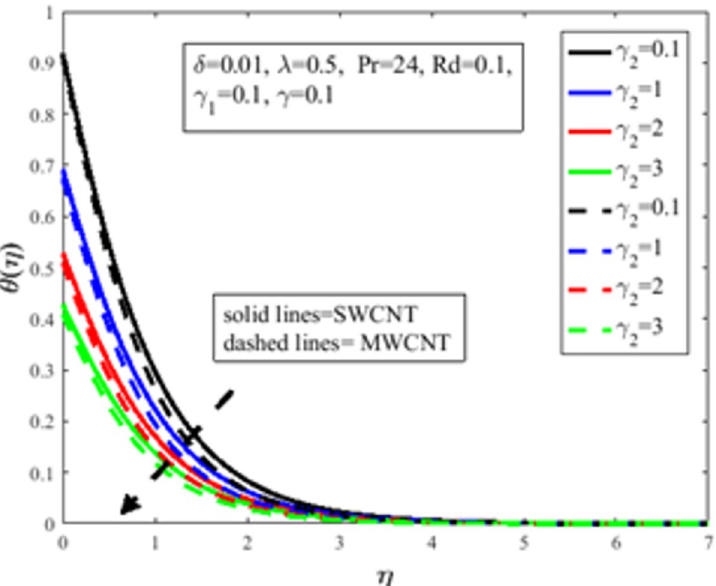
microorganisms from the liquids. Sun is the best source of thermal radiation. Radiations enhance the nanofluid temperature. In the presence of Rd heat enter more easily into the sys- tem which improves the fluid temperature and temperature field θ ( η ). Fig 12 elucidates the influence of the temperature slip factor γ on the temperature profile θ ( η ). Physically tempera- 2 ture slip phenomenon occurs when the temperature of the sheet and fluid flow over the sheet is not in thermal equilibrium. With temperature slip condition, the temperature of the